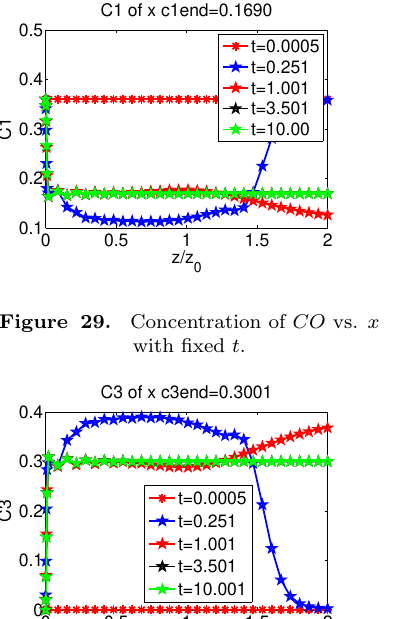
Figure 30. Concentration of H 2 O vs. x with fixed t .